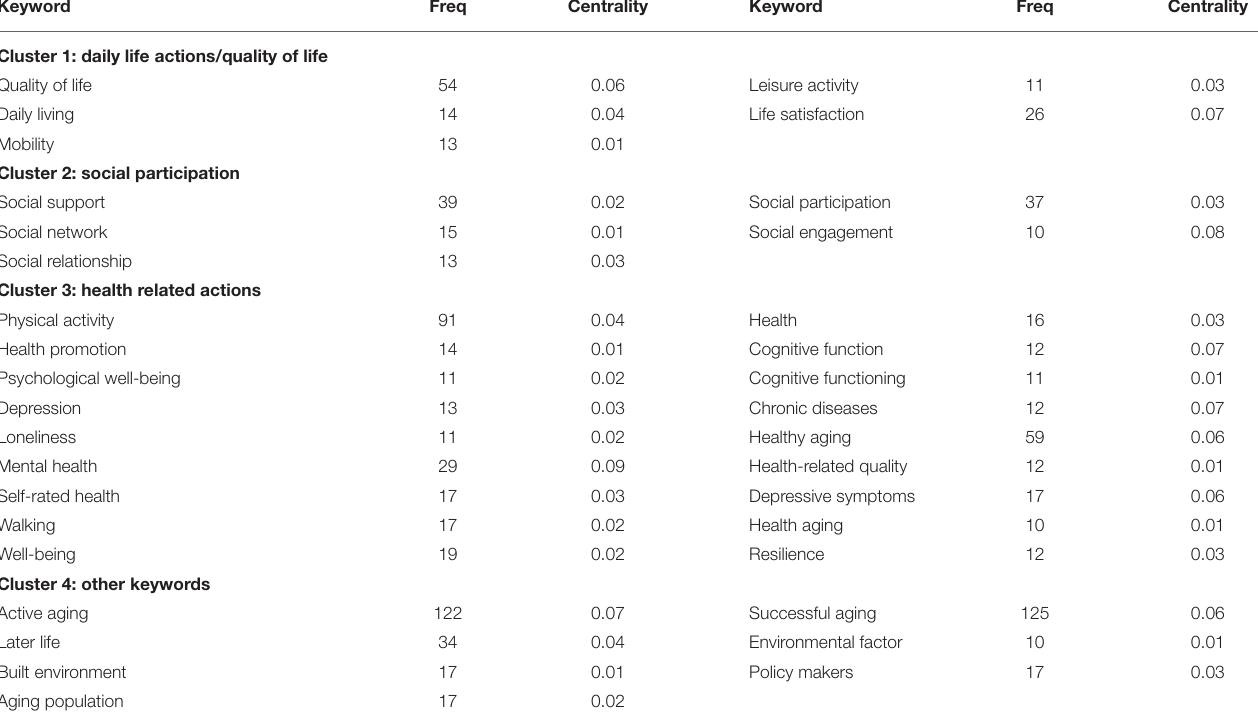
TABLE 3 | Successful aging and active